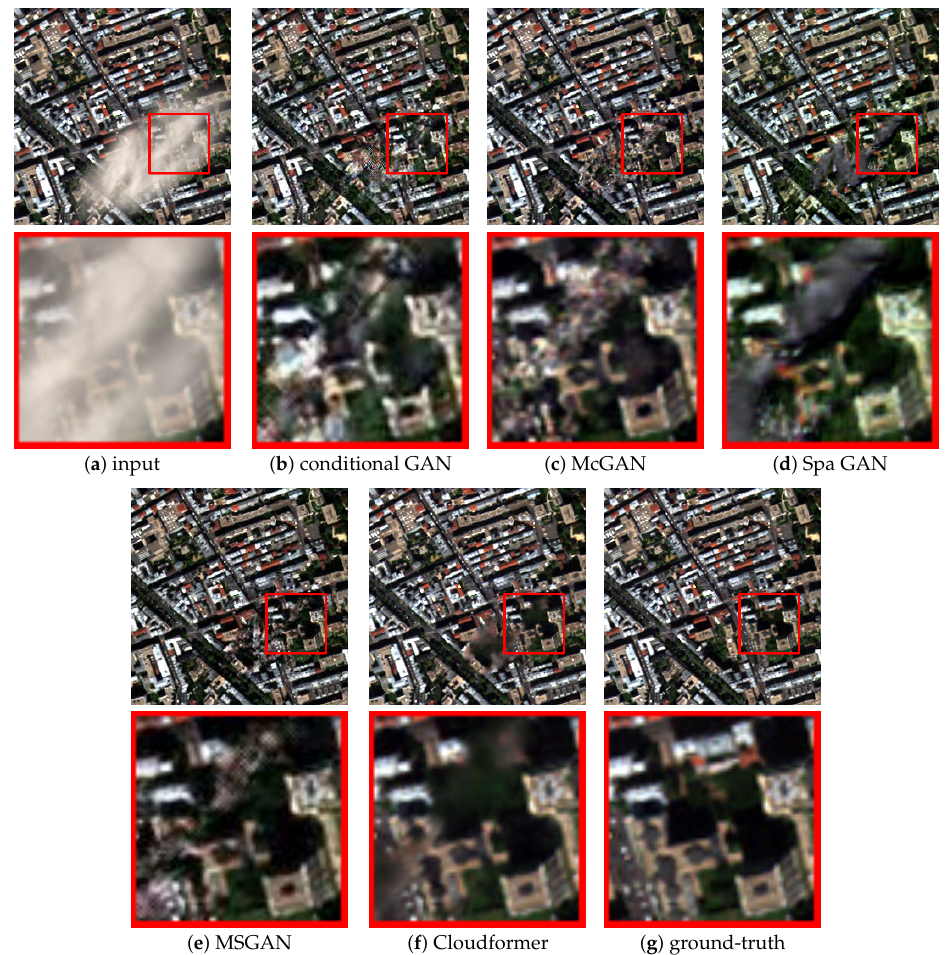
Figure 16. Comparative experimental results on second sample of Paris dataset. The result of Cloudformer is closer to the ground-truth than other compared methods in both texture and